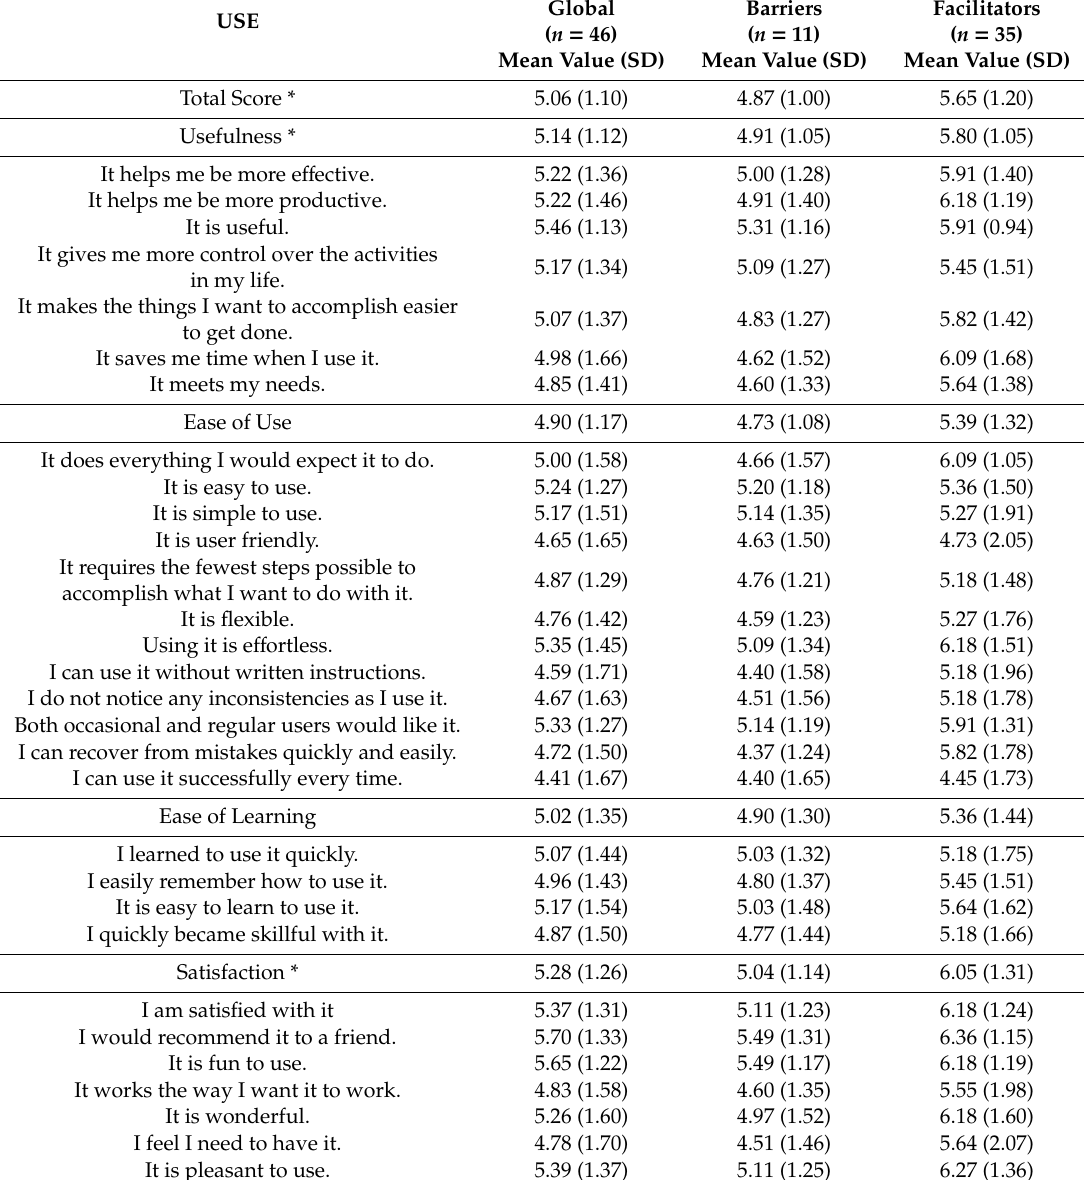
Table 2. Results of the application of